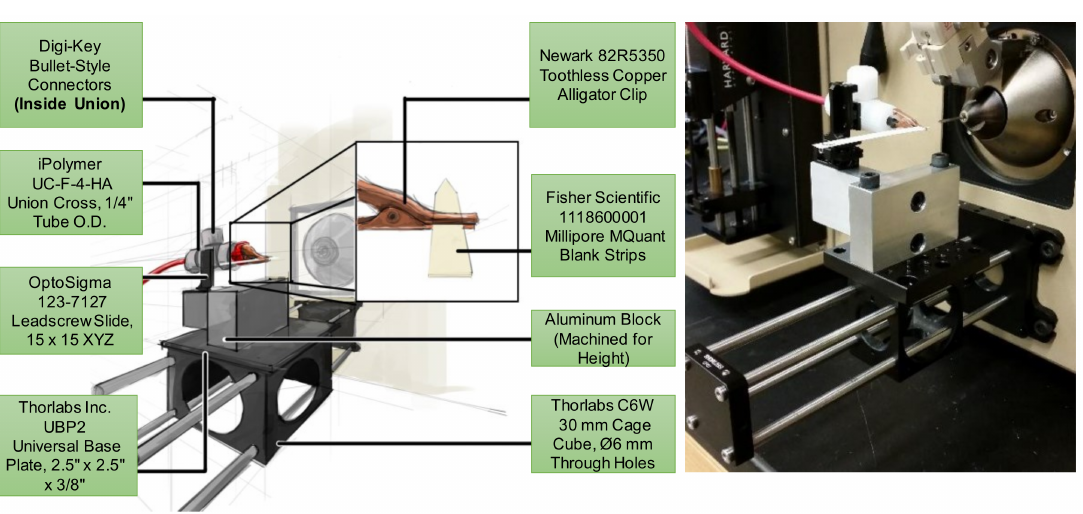
Figure 2. Simplified paper spray ionization (PSI) source module built upon the ThorLabs cage cube for the centralized mounting system. High voltage is supplied via alligator clip, which is held in place and positioned via a stock x-y-z positioner (OptoSigma). A simple Teflon union (iPolymer) is used to insulate the high voltage cable of the MS system, which terminates in a bullet-style connector that allows quick-swapping of alligator clips. Application of solvent by the user via pipette and high voltage to the paper substrate utilized produces analyte ions via electrospray-like processes. Said paper substrate can be used for dipping, spotting or physically transferring via surface swabbing chemicals of